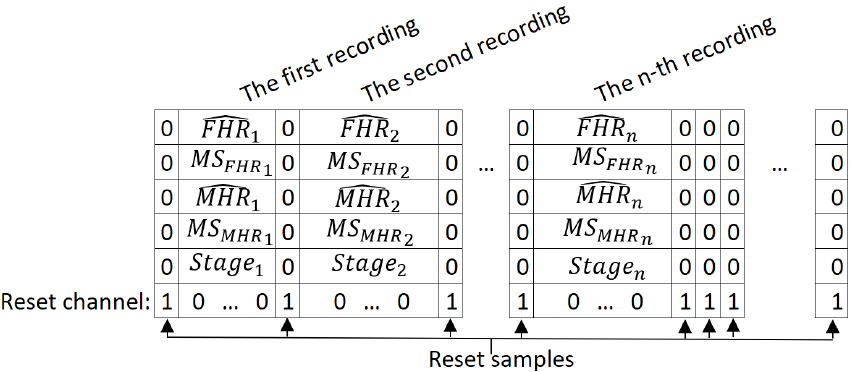
(cid:91) (cid:92) FHR and MHR are the normalized